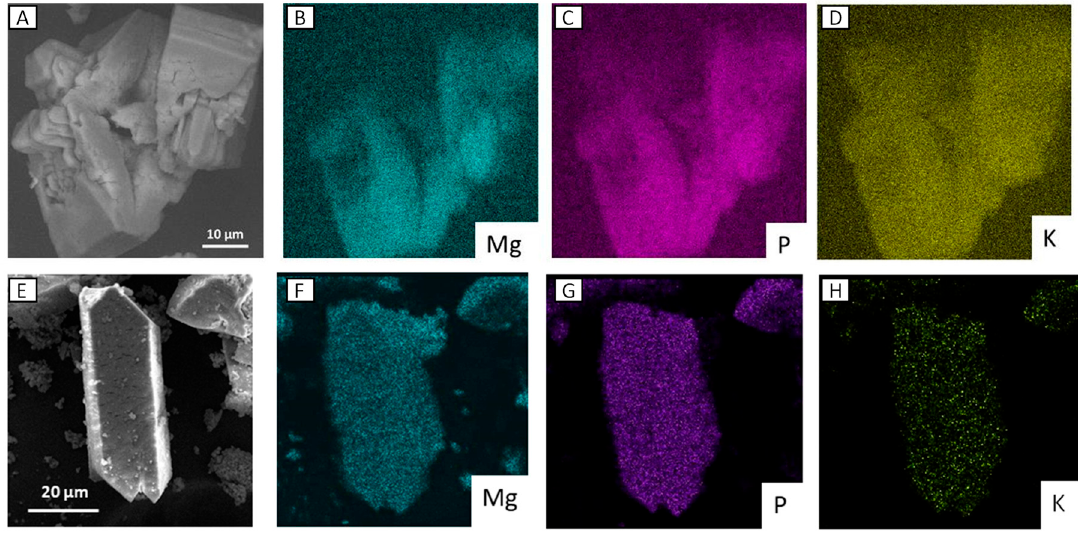
Figure 9. EDX images of MgAl 200 /K 2 HPO 4 ( A – D ) and MgFe 200 /K 2 HPO 4 ( E – H ) residues after 1 h.